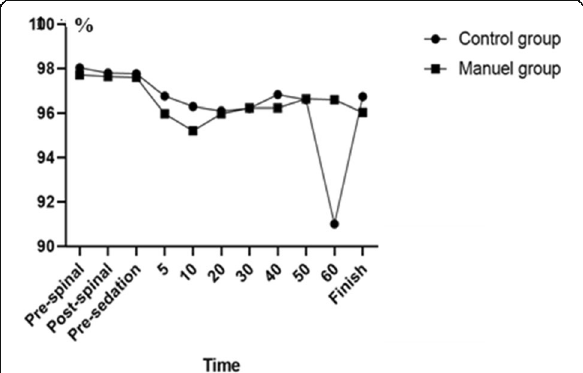
Fig. 2 Changes in mean arterial pressure. Values are mean ± SD